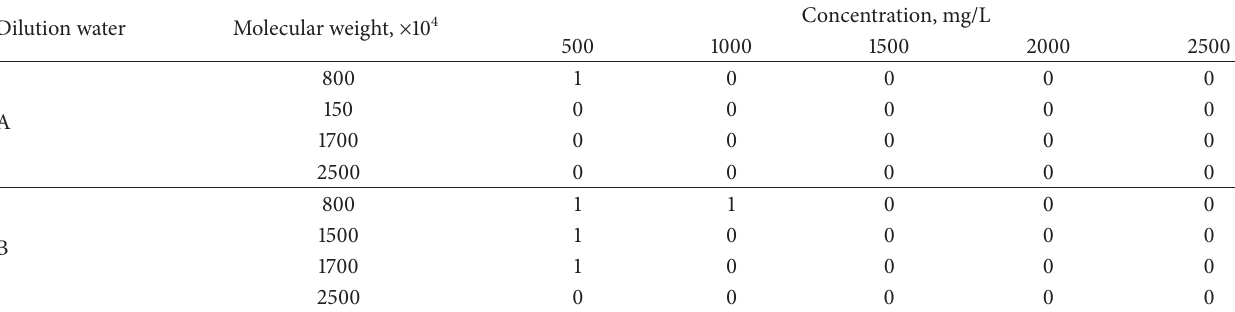
Table 5: The matching relationship plate for reservoirs with permeability 204 × 10 −3 𝜇 m 2